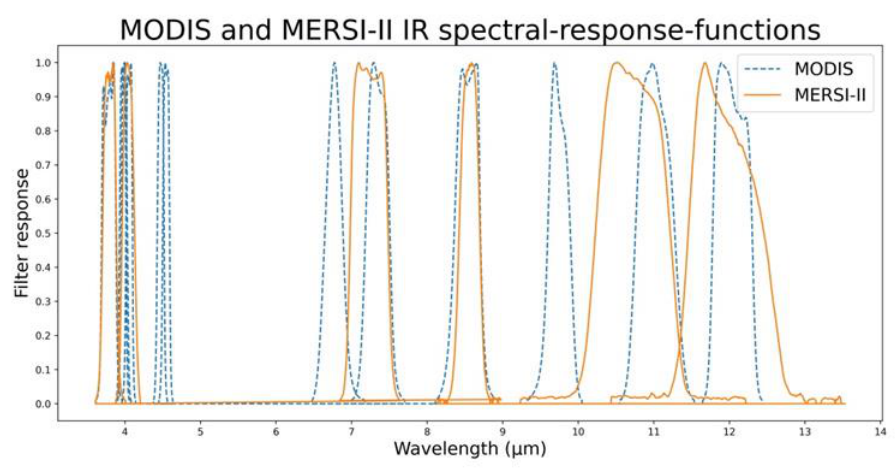
Figure 3. Spectral response functions of six IR bands of Aqua/MODIS and FY-3D/MERSI-II. The National Satellite Meteorological Center/China Meteorological Administration